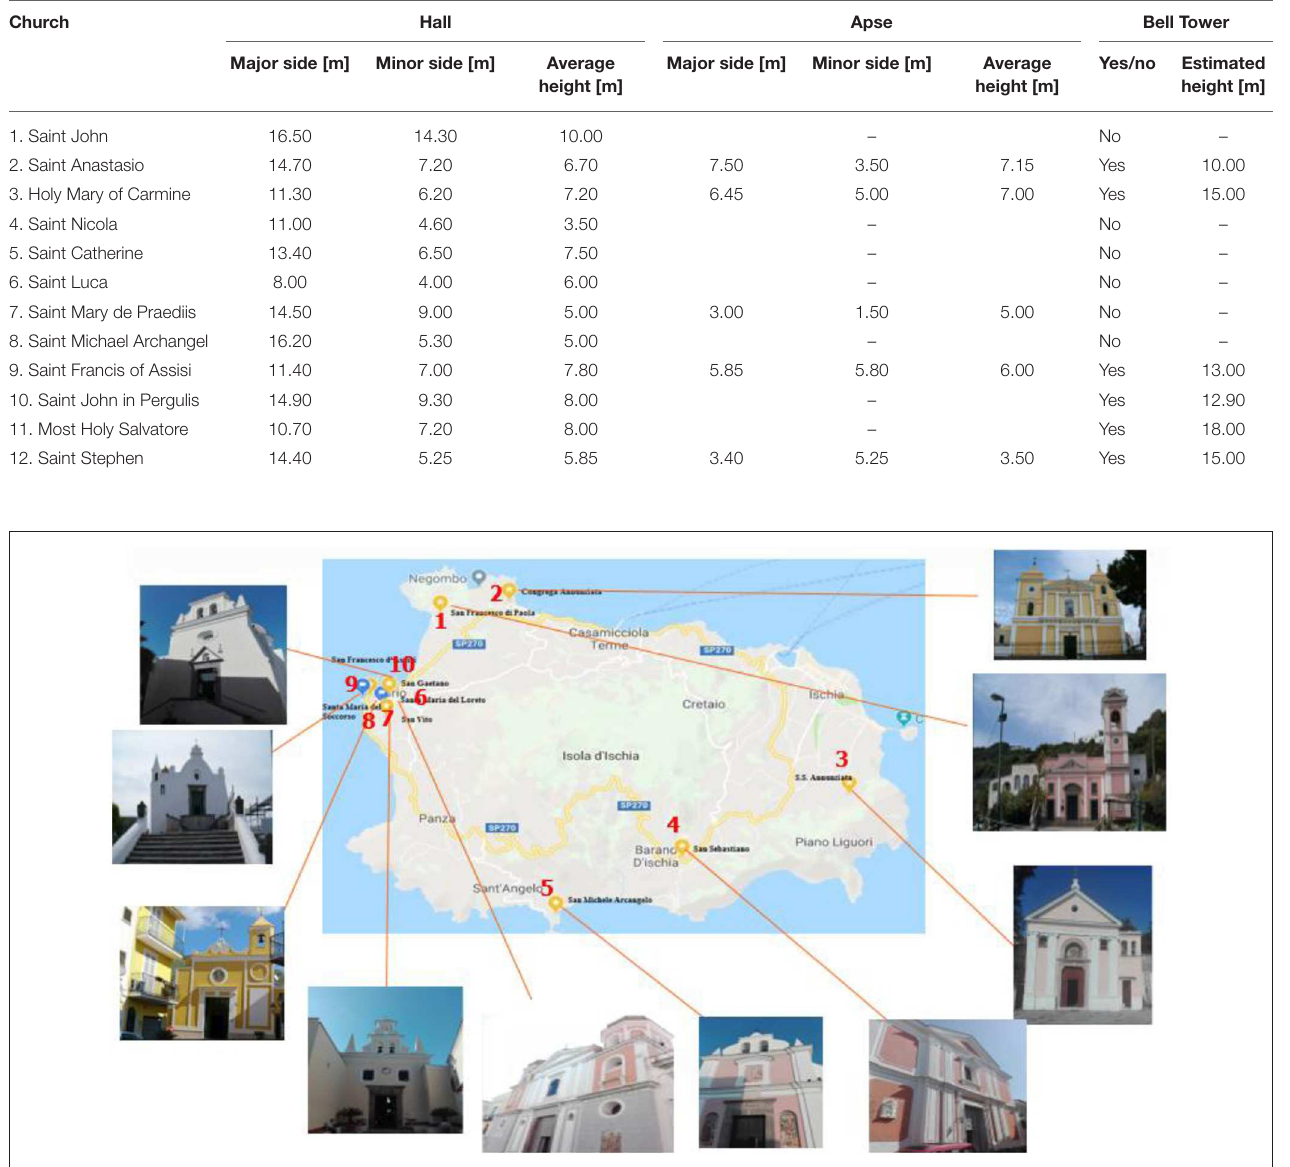
FIGURE 4 | Location of churches investigated in the island of Ischia.